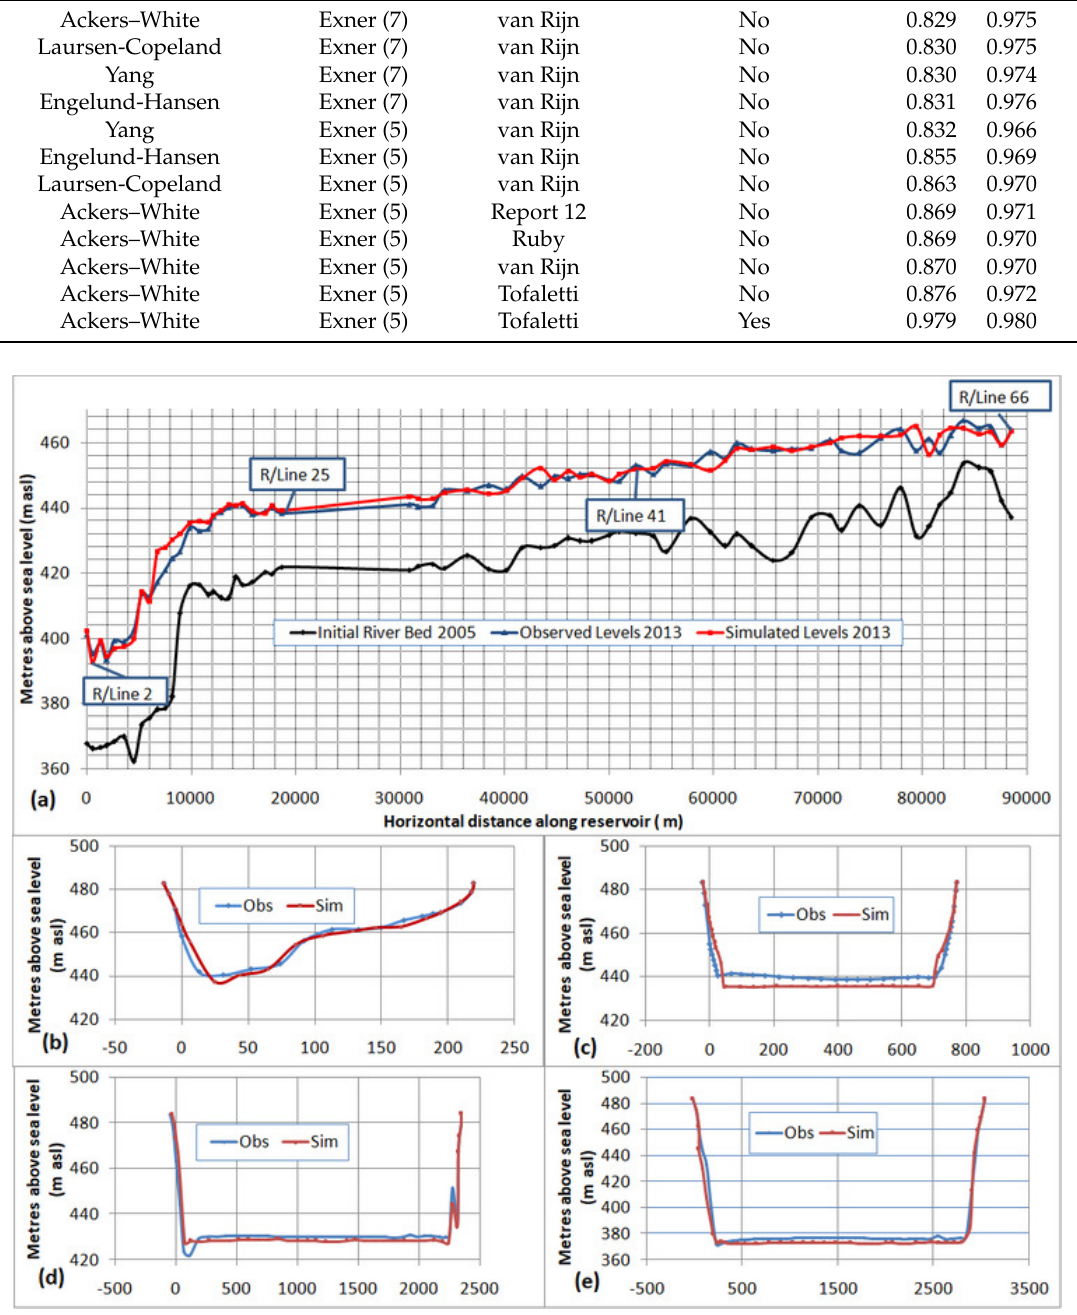
Figure 8. Comparison of observed and WA-ANN-simulated bed levels during calibration for 2013: ( a ) along the Tarbela Reservoir; ( b ) R/Line 66; ( c ) R/Line 41; ( d ) R/Line 25; ( e ) R/Line